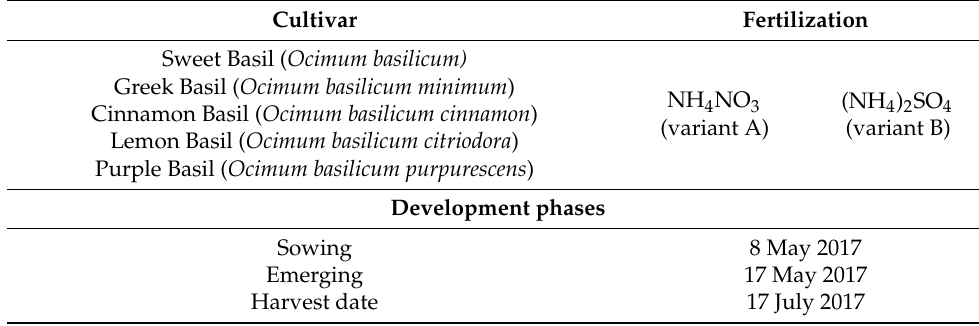
Table 2. Characteristics of chosen growth features for studied basil